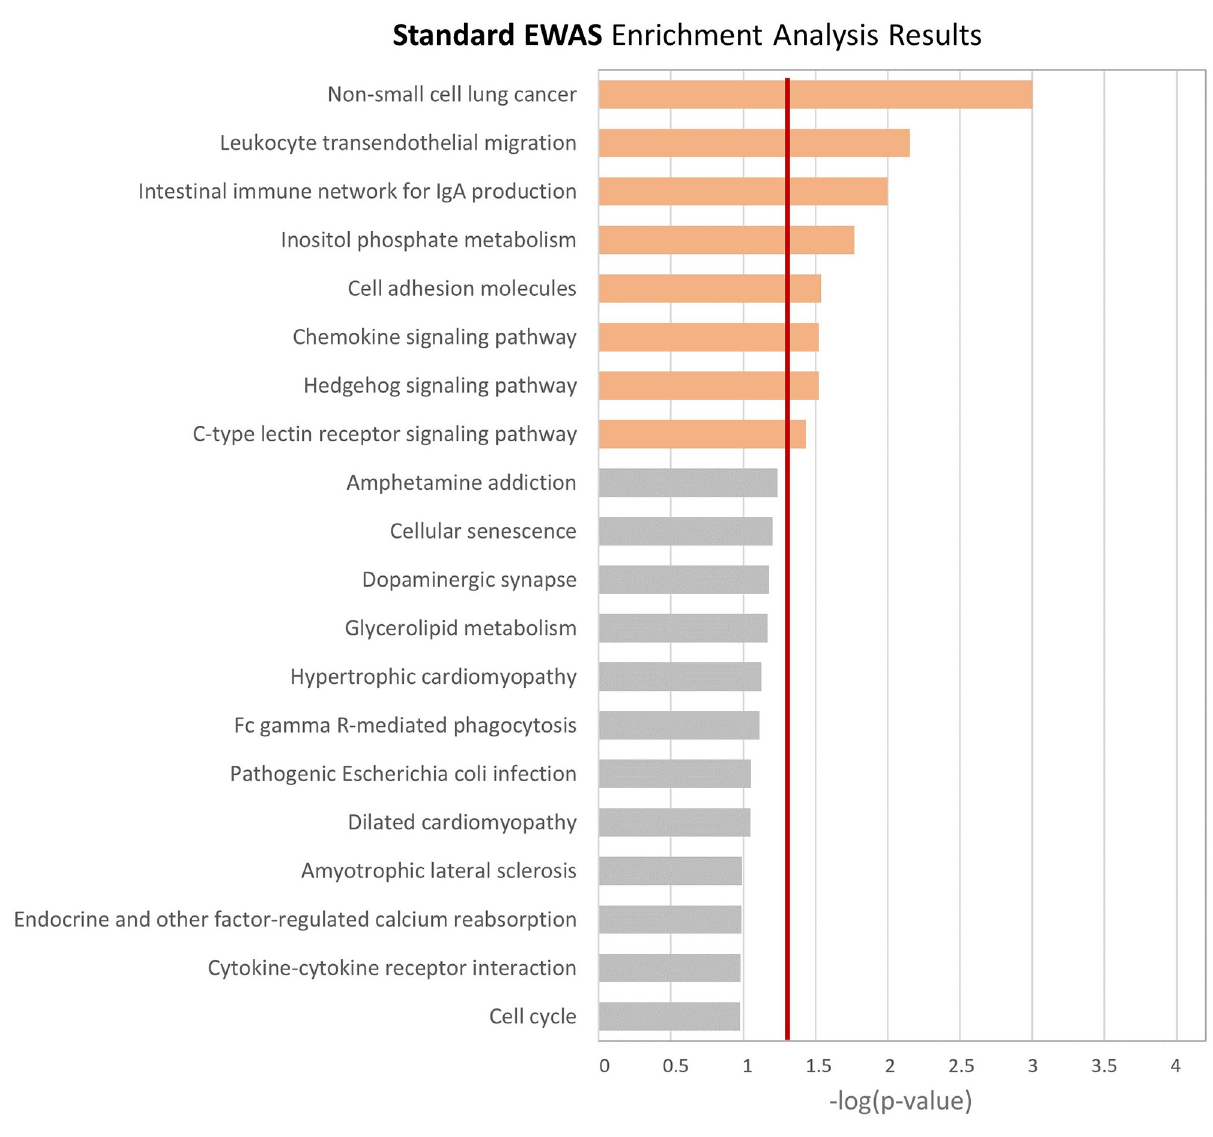
Fig 6. Weighted enrichment analysis results from standard EWAS